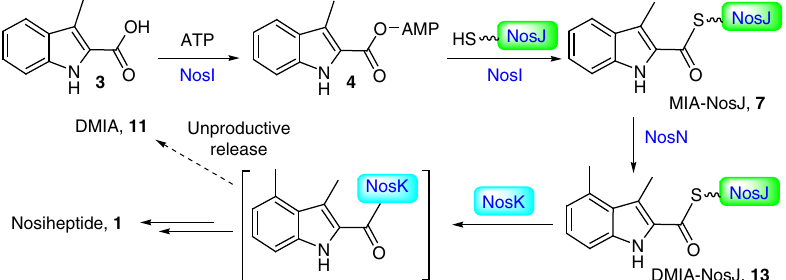
Fig. 7 The proposed biosynthetic pathway for MIA incorporation into nosiheptide biosynthesis. The NosN-catalyzed reaction occurs on the NosJ-bound MIA thioester ( 7 ) and the resulting DMIA moiety is further incorporated into nosiheptide biosynthesis by the α / β hydrolase fold enzyme